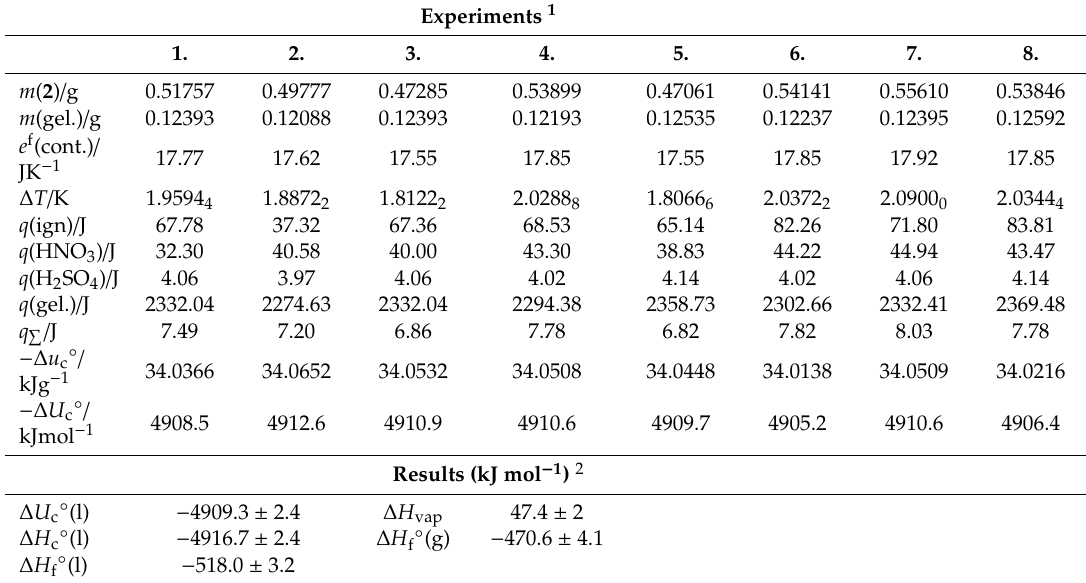
Table 1. Combustion results of 4,4,6,6-tetramethyl-1,3-dioxane ( 2 , C 8 H 16 O 2 ).